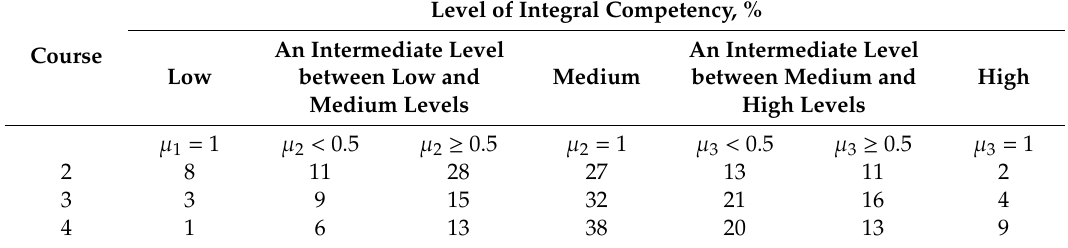
Table 3. The integral level of students’ professional competency formedness (in % of the total number of students in the